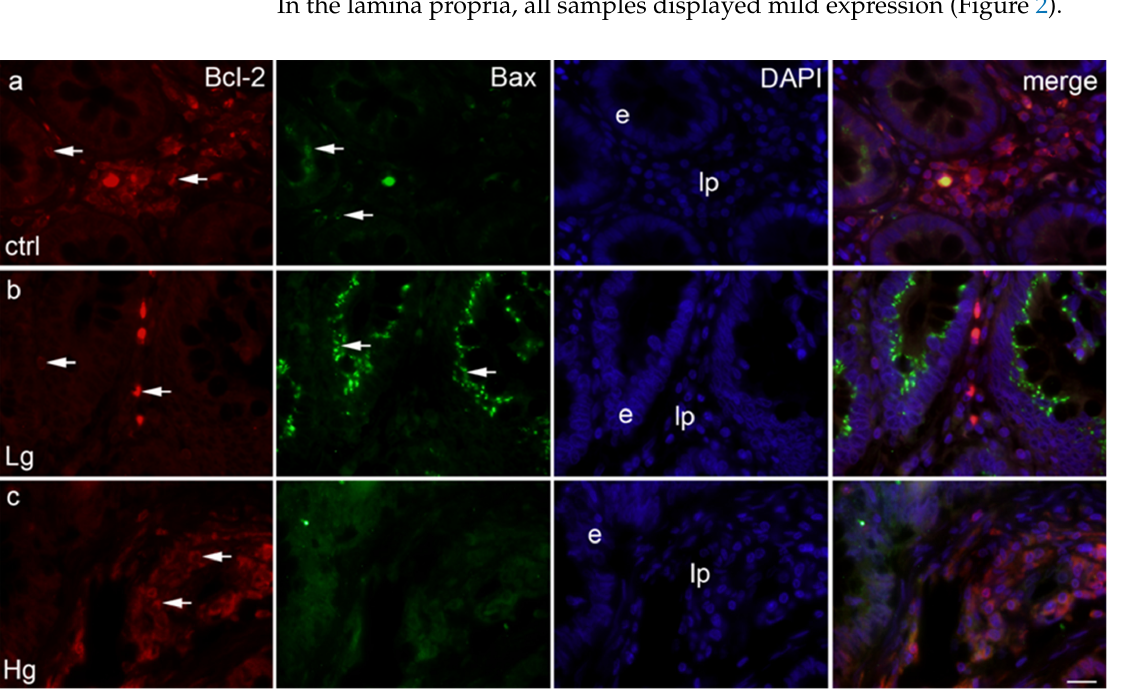
Figure 2. Section through the healthy human colon tissue (ctrl) ( a ), section through the human low-grade colon cancer (Lg) ( b ), section through the human high-grade colon cancer (Hg) ( c ); positive cells (arrows), lp–lamina propria, e-epithelium. Triple immunofluorescence staining for Bcl-2 (red), Bax (green) and DAPI (blue), scale bar 10 µ